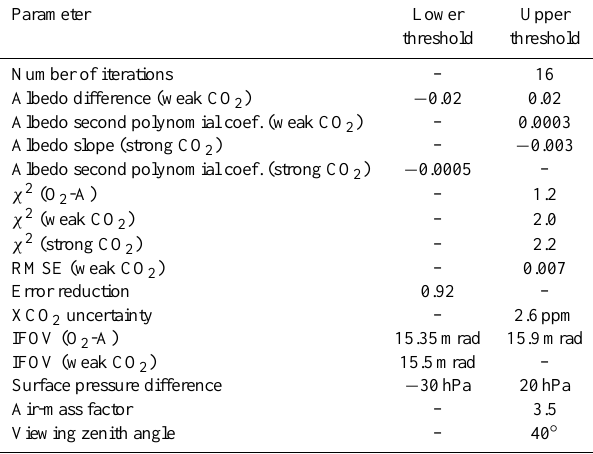
Table 3. Parameters and thresholds as used for the quality filtering. A scene is considered to be of “good” quality if e.g. the albedo difference between the fitted and a priori albedo in band 2 (albedo difference, weak CO 2 ) is larger than the lower threshold of − 0 . 02 and smaller than the upper threshold of 0.02.